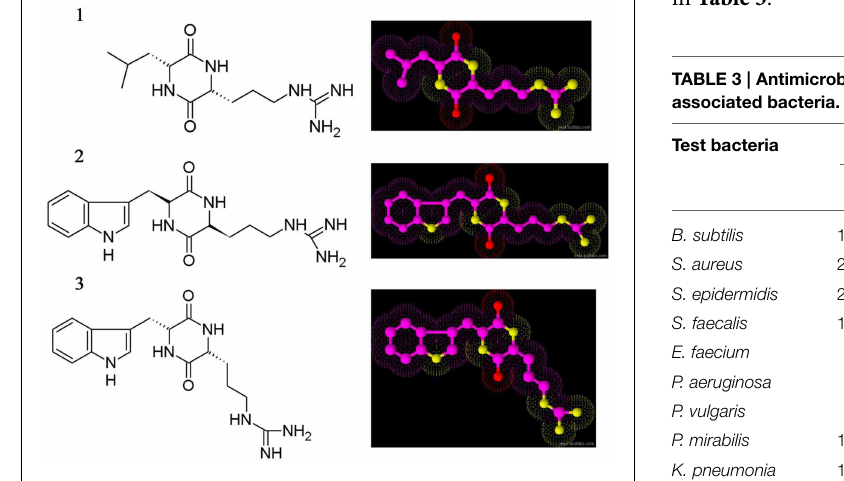
FIGURE 3 | Chemical structure of cyclic dipeptides. Cyclo(D-Leu-D-Arg) (1), Cyclo(L-Trp-L-Arg) (2), and Cyclo(D-Trp-D-Arg) (3).